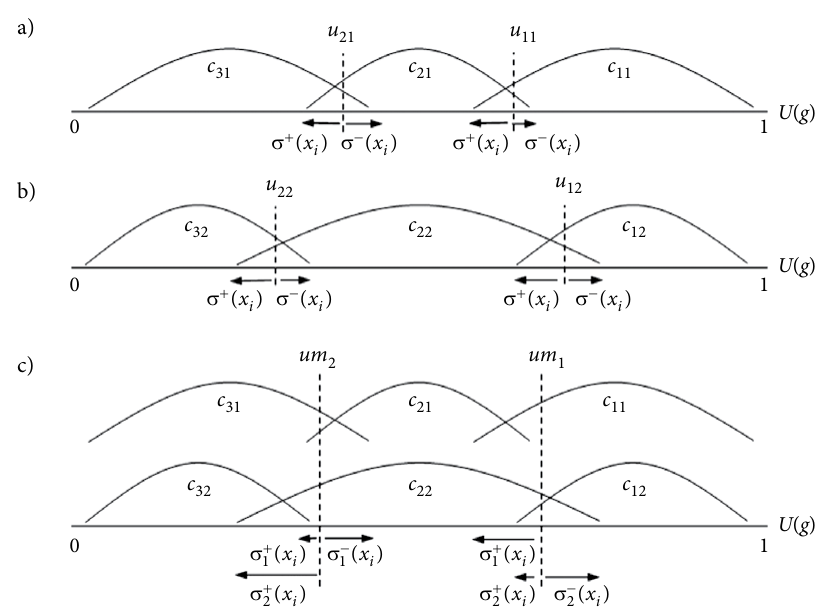
Fig. 3. Representation of misclassification errors of standard and multiple classification UtADiS methodologies for a two classification criteria and predefined three classification groups